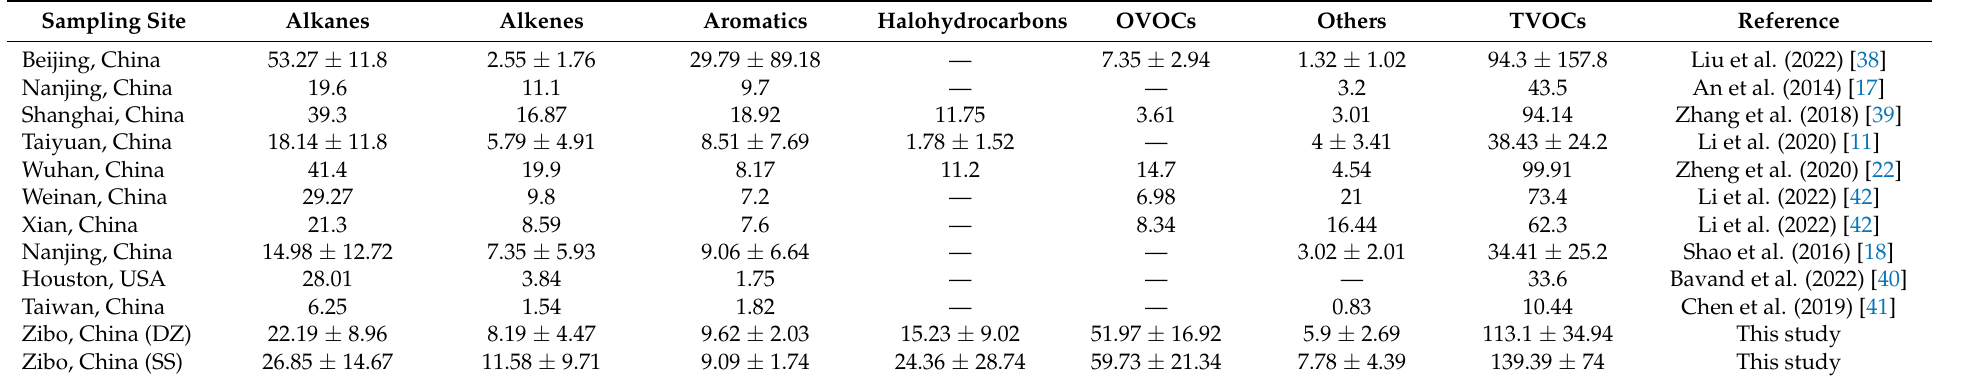
Table 1. Comparison of VOC concentrations at different industrial sites (unit: